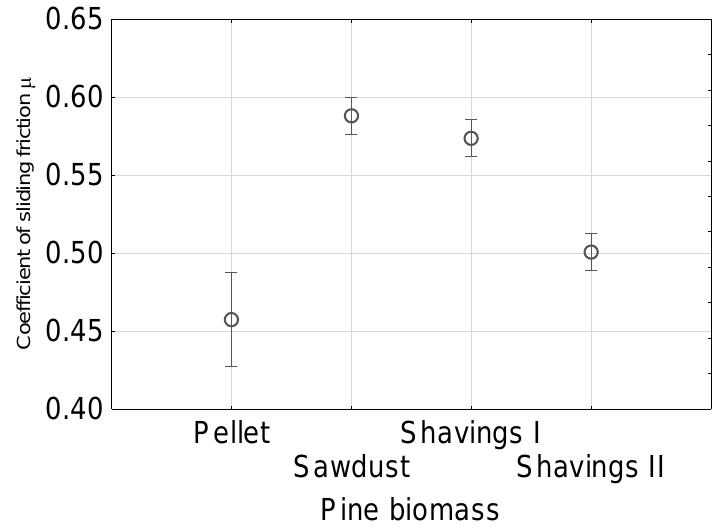
Figure 4. Mean value of the coefficient of sliding friction with 0.95 confidence intervals for different types of pine biomass and construction materials.